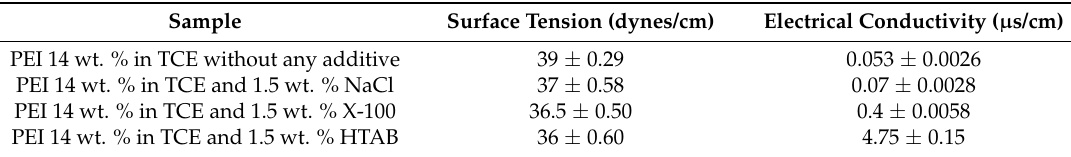
Table 1. Surface tension and electrical conductivity of electrospinning solutions. All the readings were obtained at room